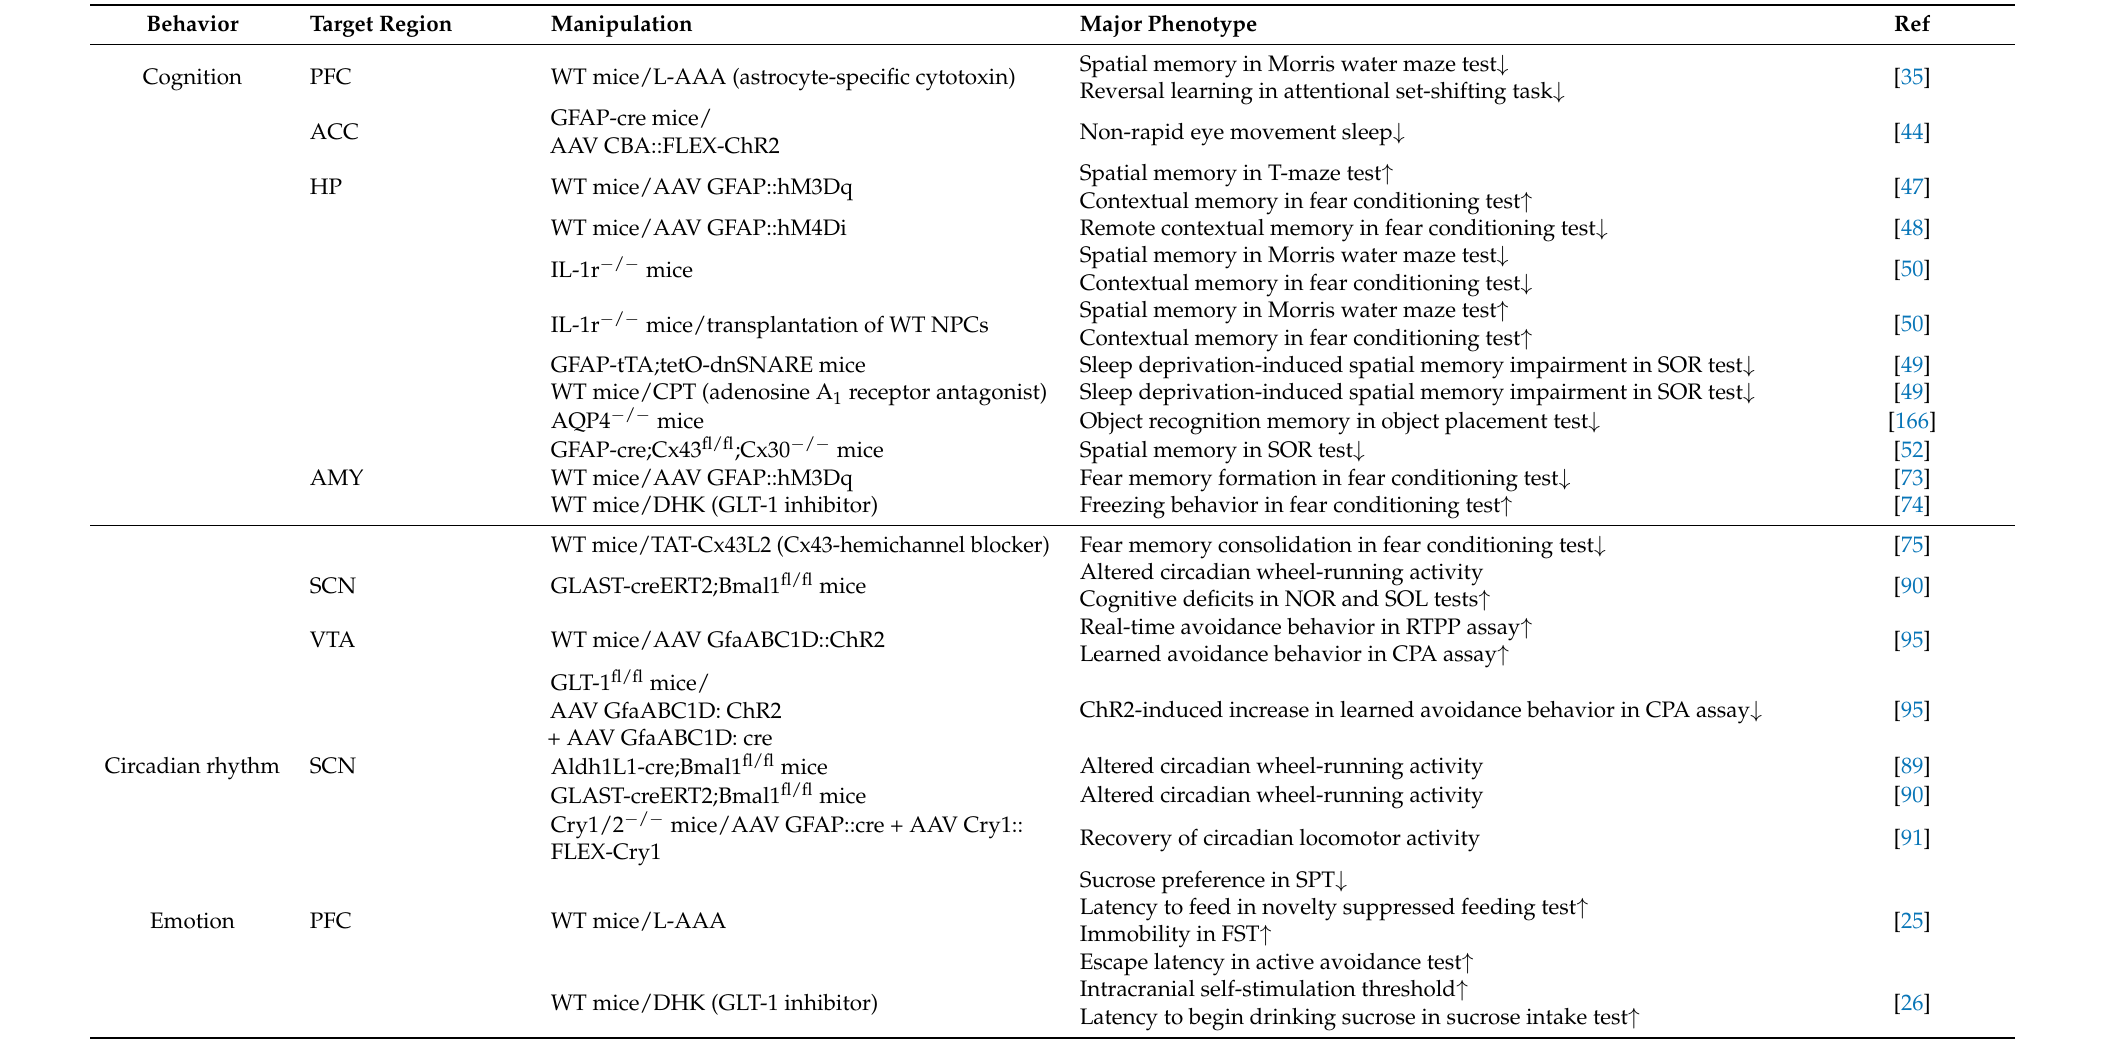
Table 2. Behavioral results of astrocyte-specific